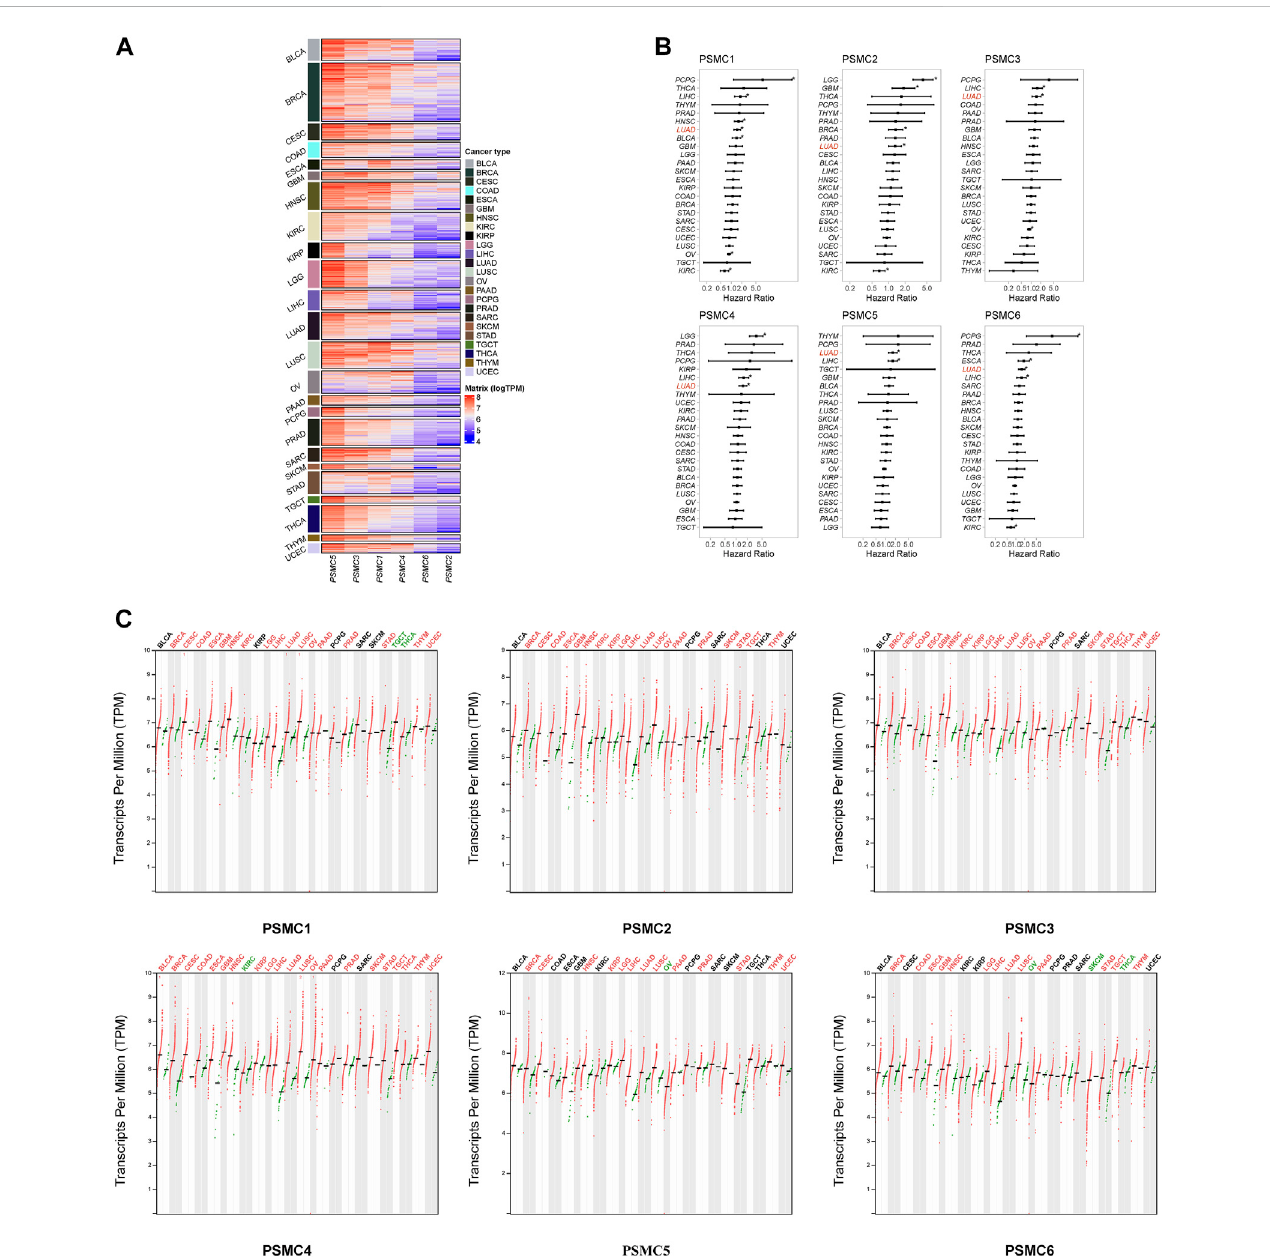
FIGURE 1 Expression of proteasome 26S subunit, ATPase (PSMC) genes across different types of cancer. (A) Heatmap representing the expression level of the six PSMCfamilygenesinpan-cancer. (B) ForestplotsillustratingthehazardratiooftheexpressionlevelsofPSMCgenesrelatedtooverallsurvivalusingunivariate Cox analysis. (C) Comparison of the expression levels of the six PSMC family genes between tumor and normal tissues in 24 types of cancer. Cancer types labeled black indicated no signi fi cantdifference betweentumor and normal tissues; red indicated that the expression level was signi fi cantly upregulated in the tumor tissues; and green indicated that the expression level was signi fi cantly downregulated in the tumor